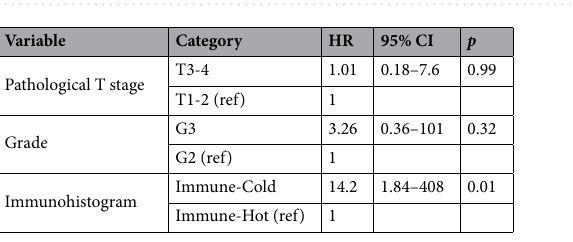
Figure 2. Survival outcomes after ICI therapy according to immunohistogram groups. ( A ) Progression-free survival (PFS), ( B ) cancer-specific survival (CSS).